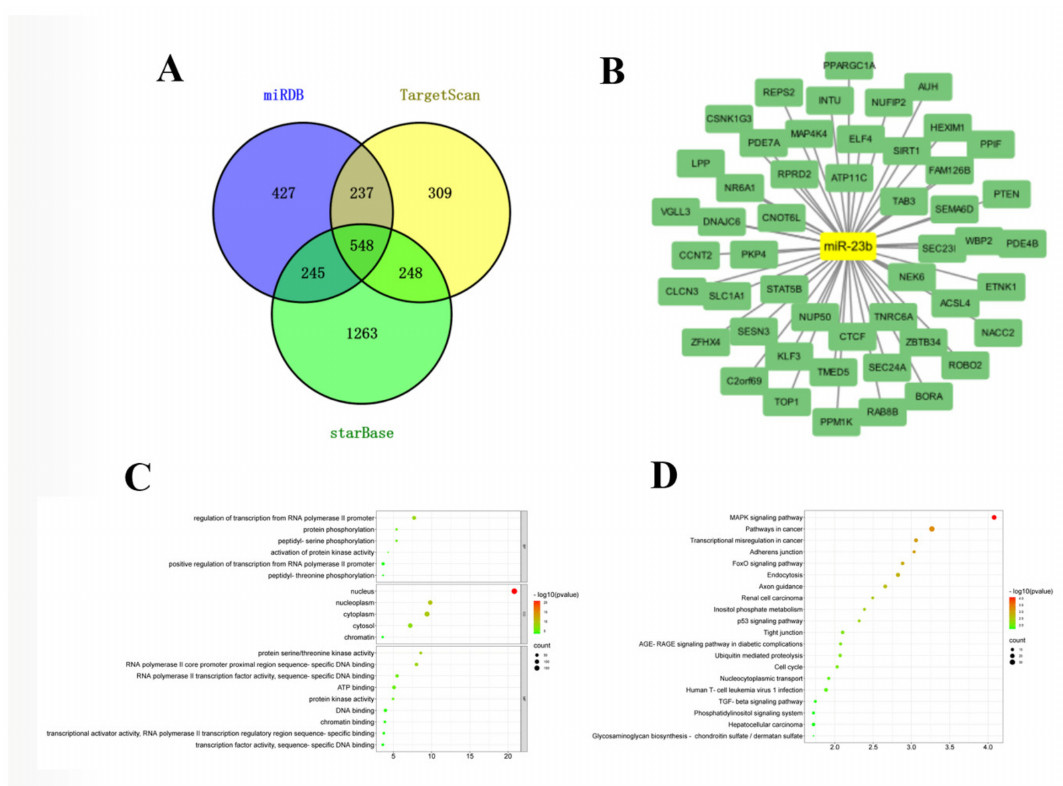
Figure 3. Prediction of target genes of miR-23b and functional enrichment analysis of target genes. ( A ) Online software predicted the number of target genes of miR-23b; ( B ) miR-23b-target genes network; ( C , D ) the results of GO and KEGG of target